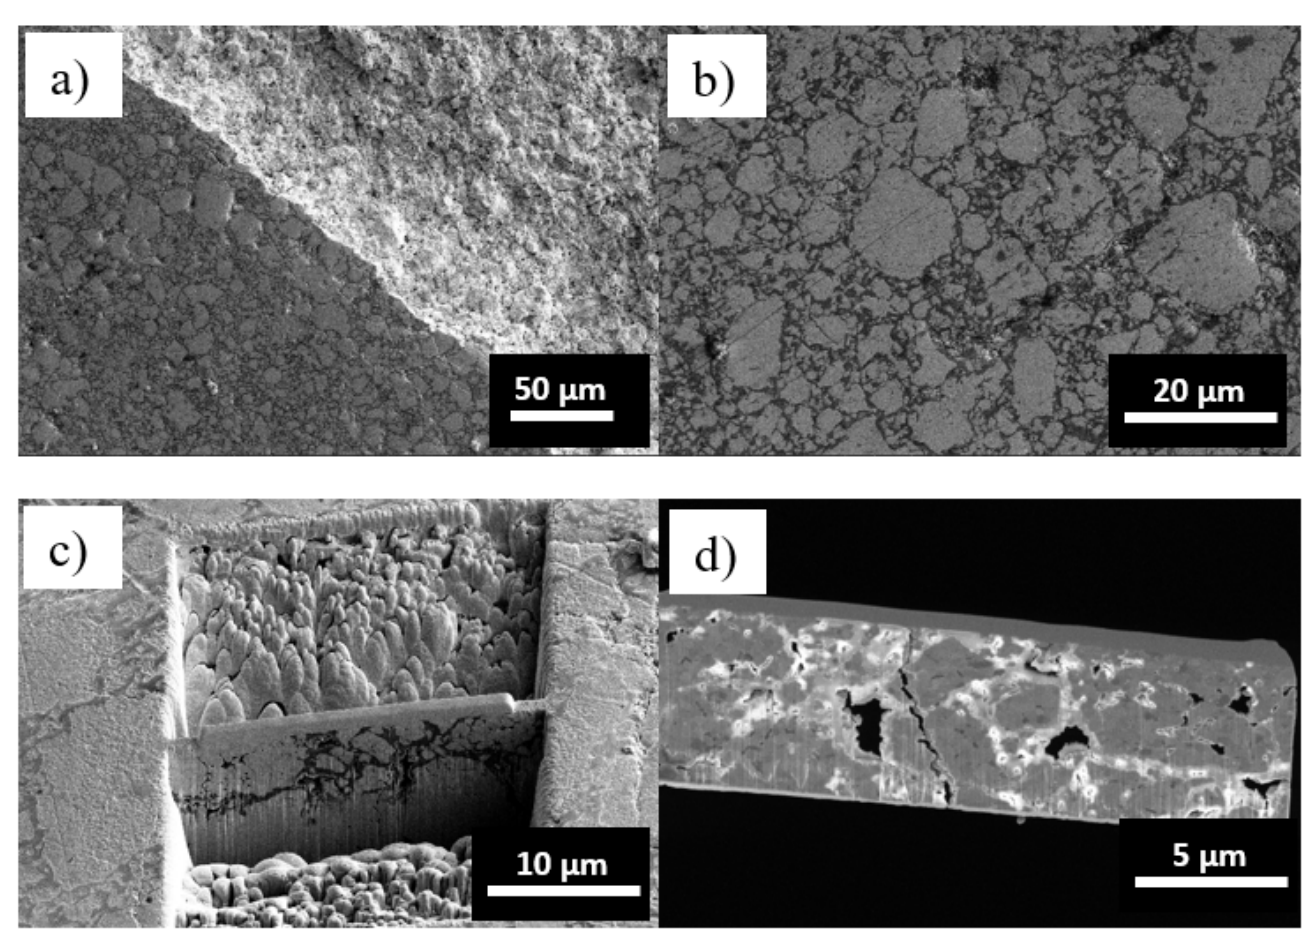
Figure 6. SEM micrographs of W 80 Al 20 powders after 12 h of annealing at 900 °C. ( a ) Cross-section of a fractured area; ( b ) A detail of the microstructure highlighting partial sintering; ( c ) Preparation of the TEM lamella ( d ).